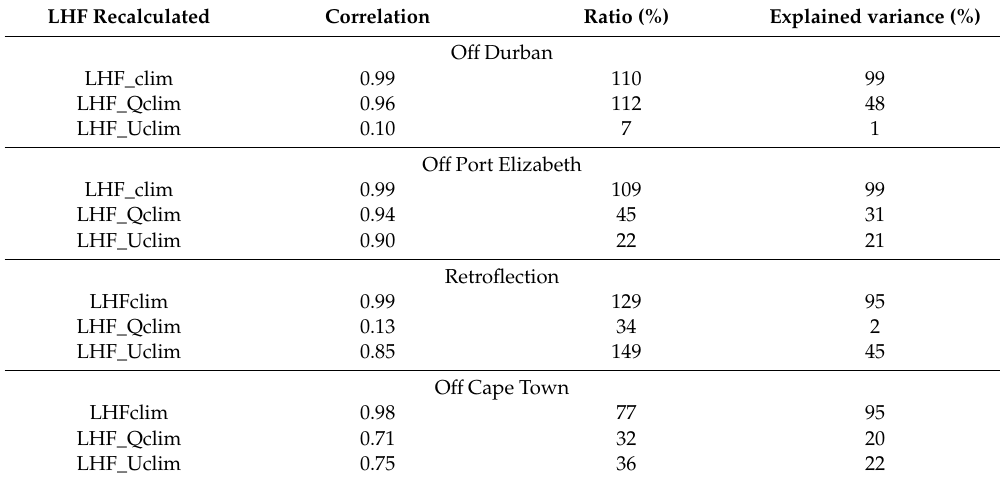
Table 6. Correlations, ratio of variances and explained variances between SEAFLUX latent heat flux (LHF) and SEAFLUX LHF recalculated o ff Durban, o ff Port Elizabeth, Retroflection region and o ff Cape